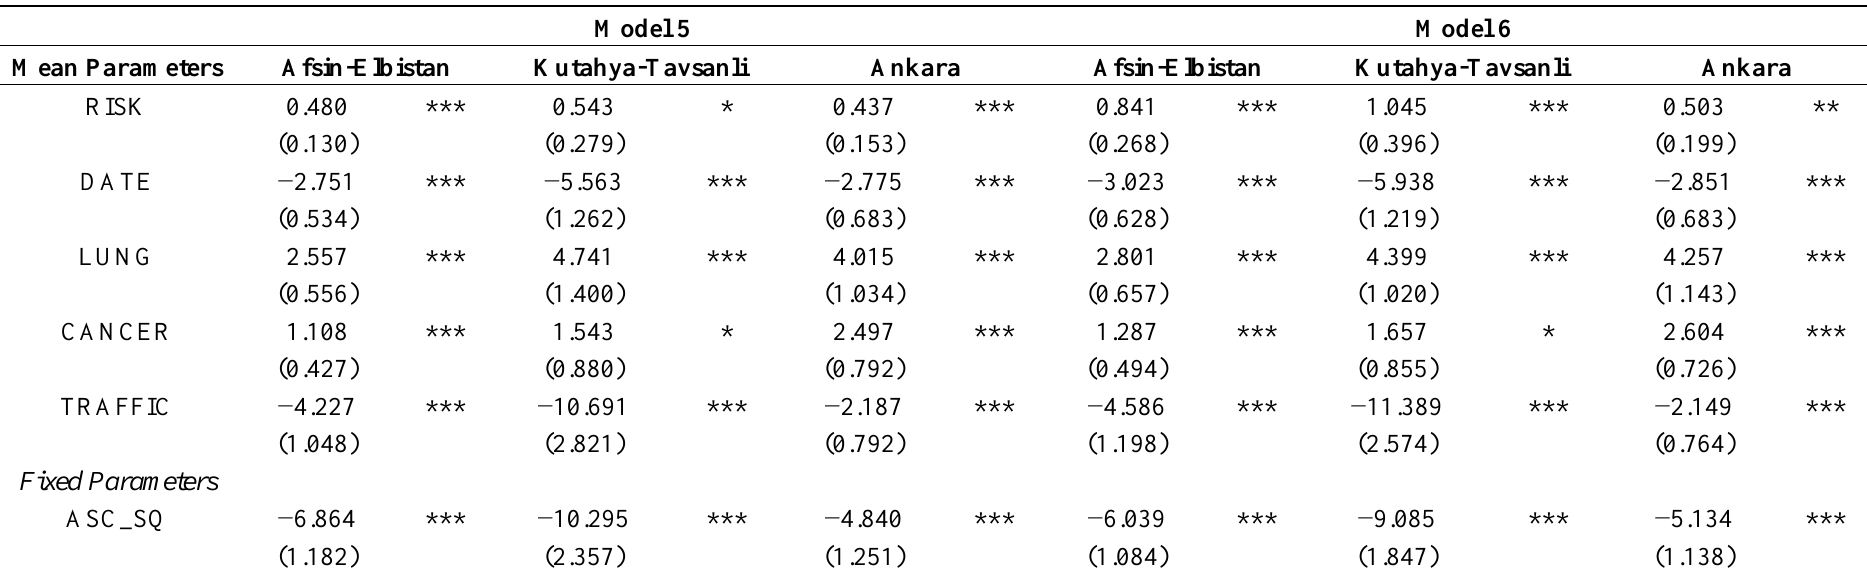
Table 10. Estimated Results for Model 5 (ASC_SQ Cross Terms) and 6 (RISK Cross